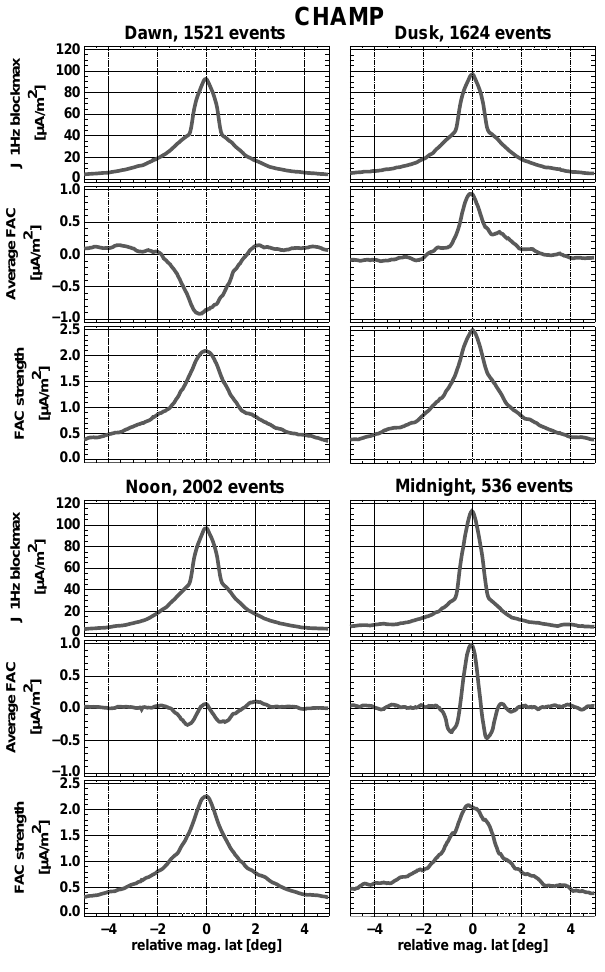
Fig. 15. Superposed Epoch Analysis: relative location of KSFAC bursts with respect to large-scale field-aligned currents for four dif- ferent MLT intervals. 05:00–10:00 MLT (dayside dawn), 09:00– 13:00 MLT (noon = cusp region), 12:00–17:00 MLT (dayside dusk, upper right) and 21:00–02:00 MLT (midnight = substorm